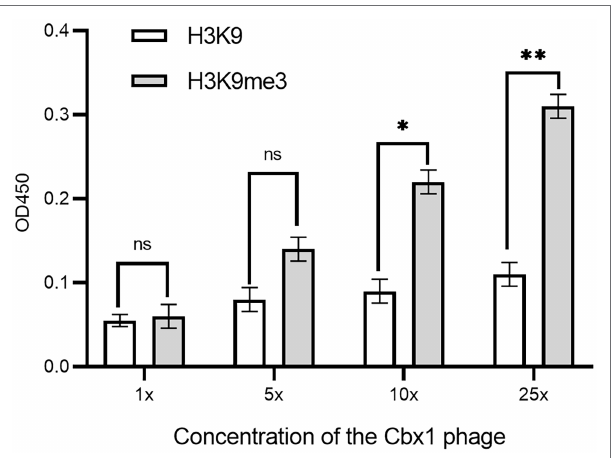
FIGURE 2 | ELISA signals were plotted as a function of the Cbx1-containing phage with different phage concentrations added to the streptavidin-coated wells conjugated with biotinylated H3K9me3 or H3K9 peptides as the negative control. 1x concentration represents a solution with a phage concentration similar to the supernatant phage. The experiments were repeated three